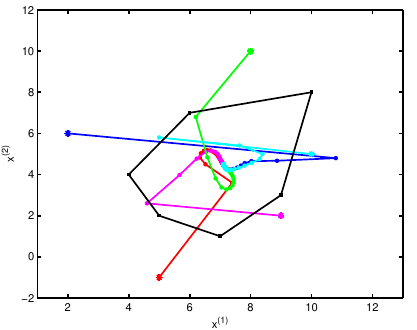
Figure 5. Trajectories of agents with symmetric topology.